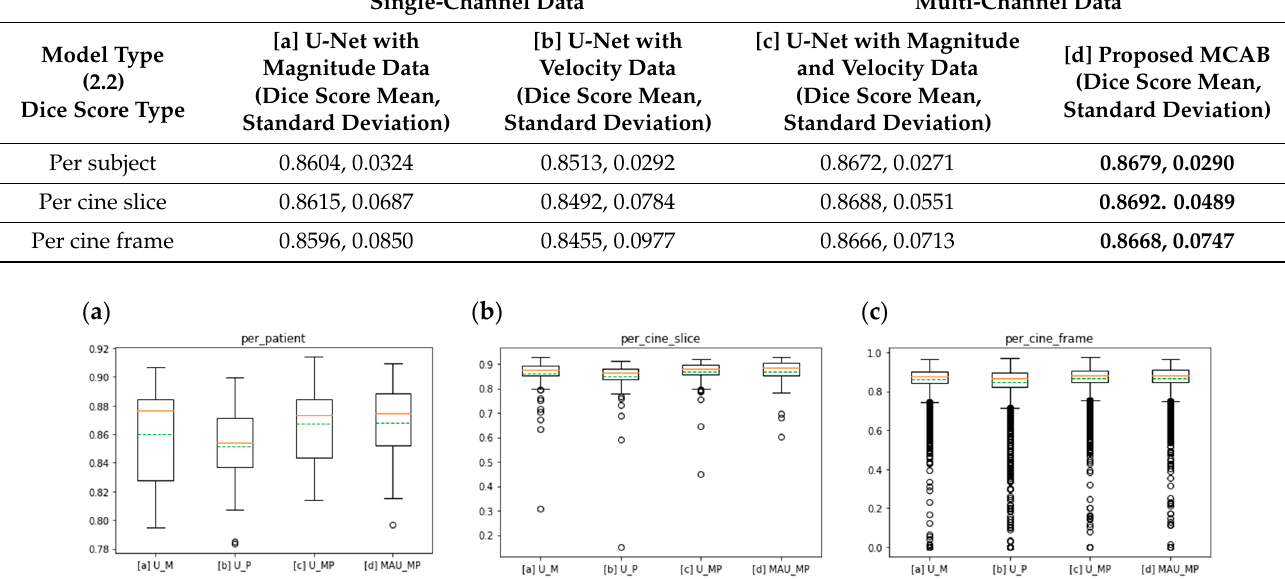
Figure 3. Boxplot of Dice Scores for different models ( a – c ), and [d] per subject, ( a ) per cine slice ( b ) and per cine frame ( c ) of the comparison study results in five-fold cross-validations using different methods. In the boxplot, the orange line indicates the median value, the green line indicates the mean value and the dots around indicate the outliers. Outliers here are defined as data points above Q3 + 1.5 × IQR or below Q1 − 1.5 × IQR of the distribution. (Q1: first quartile, Q3: third quartile, IQR: interquartile range (Q3–Q1).)